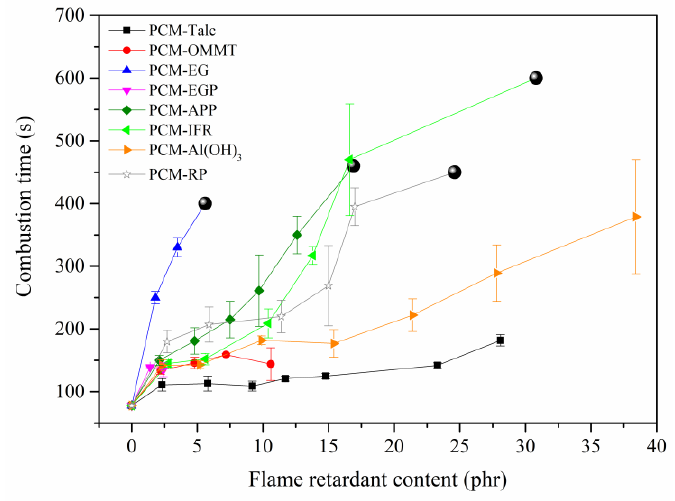
Figure 1. Horizontal burning results of paraffin-based shape-stabilized phase change materials (SSPCMs) coated with different flame retardants ( : self-extinguish).